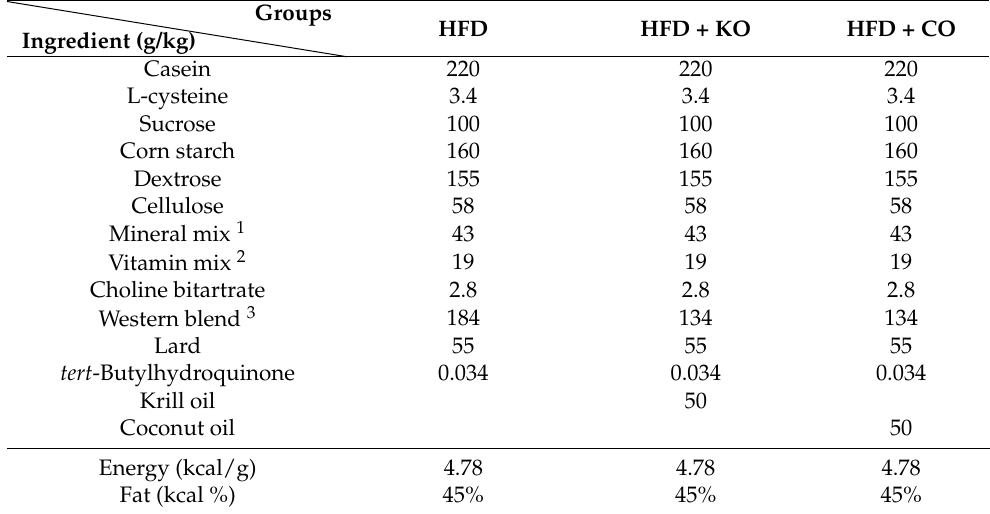
Table 1. Composition of the experimental